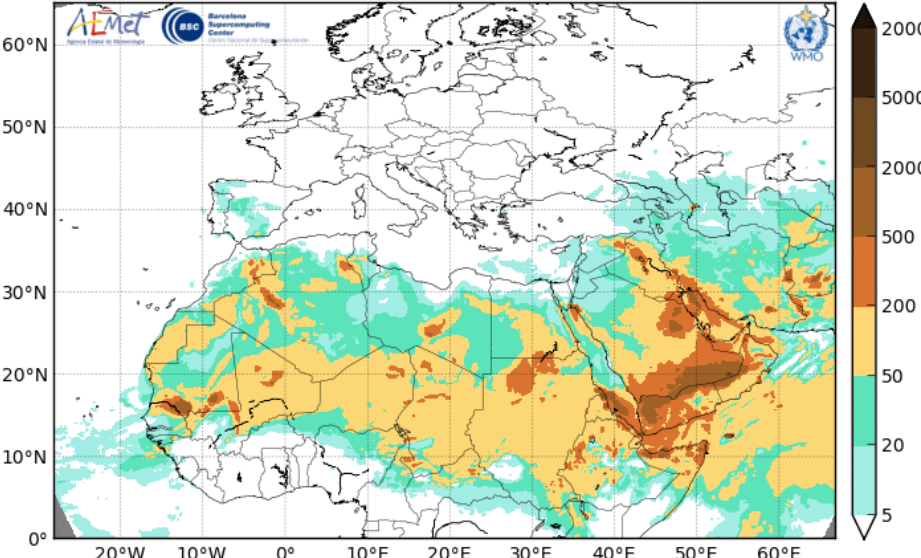
Figure 10. Dust surface concentration image from the Barcelona Dust Forecast Center showing that the SDS on 23 August 2018 originated from the two hotspots affecting the Arabian Gulf and east Arabia. Table 3. Change in SDS source areas (increase and decrease) with time (1968, 1984, 1991, 2000, 2013, and 2020).